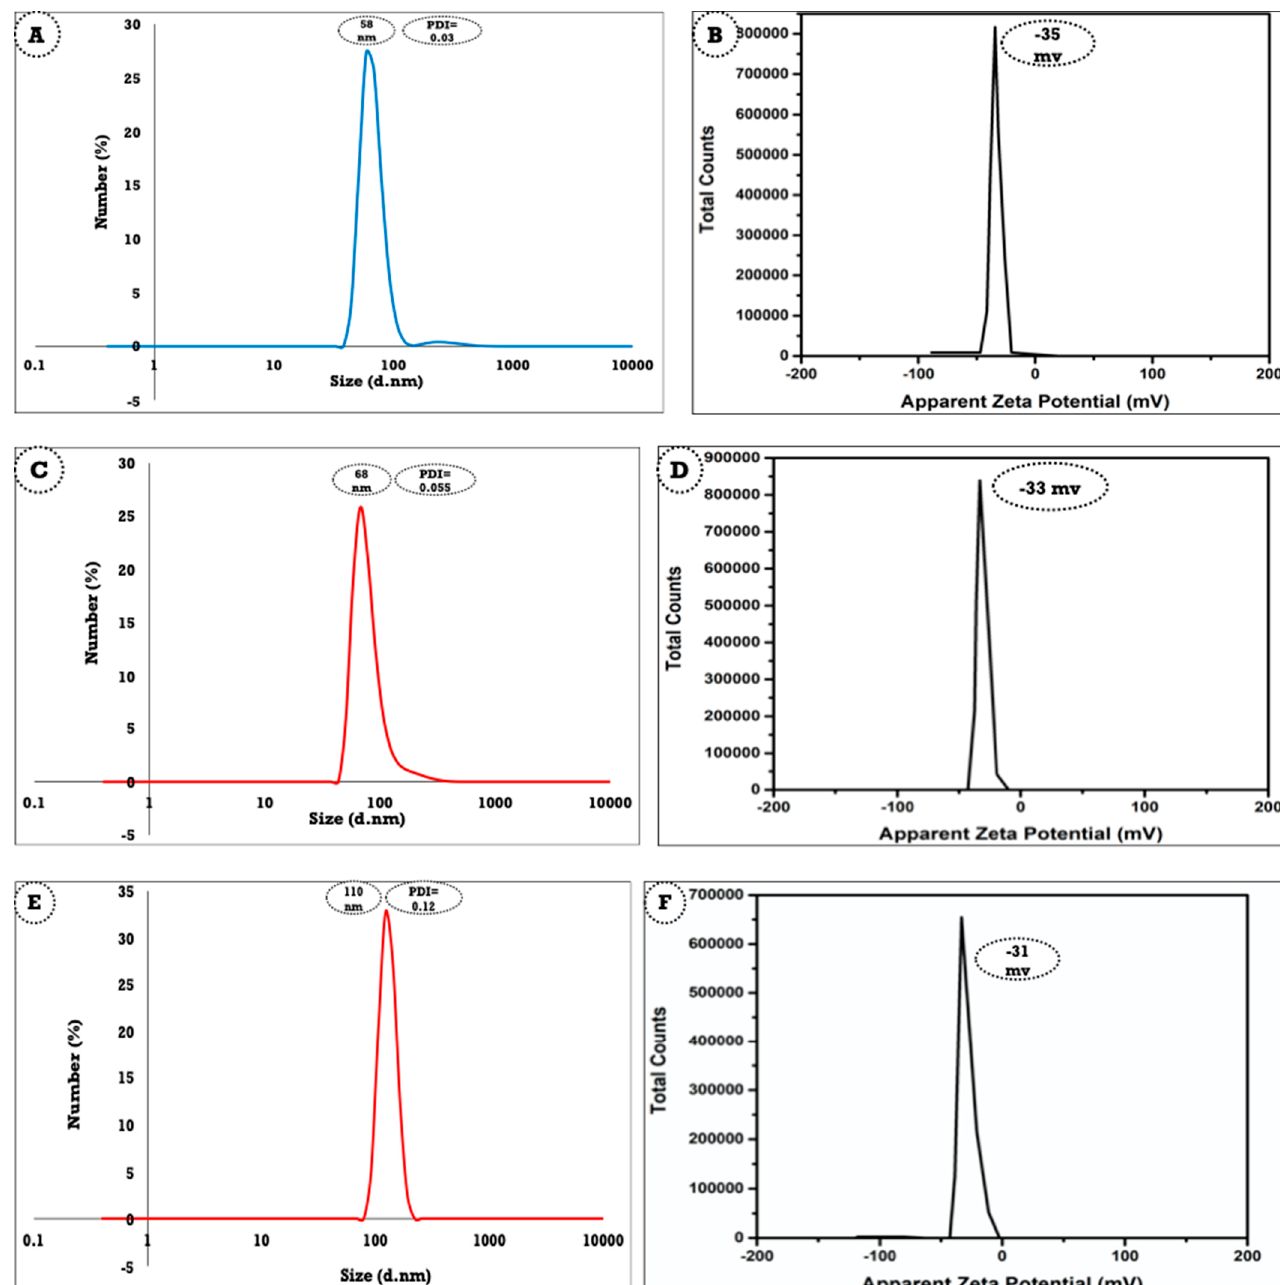
Figure 3. Particle size analyzer and zeta potential of anise oil-based nanoemulsion using ( A , B ) 5.5 mL, ( C , D ) 9.5 mL, and ( E , F ) 13.5 mL of anise oil, respectively.